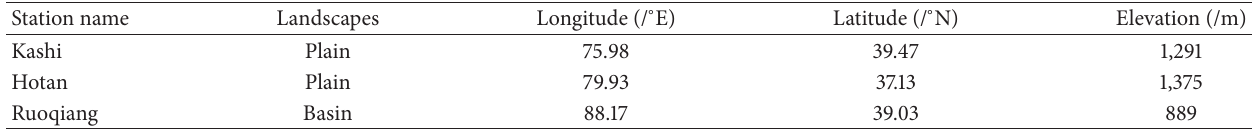
Table 1: The stations of the Southern Tarim River Basin.